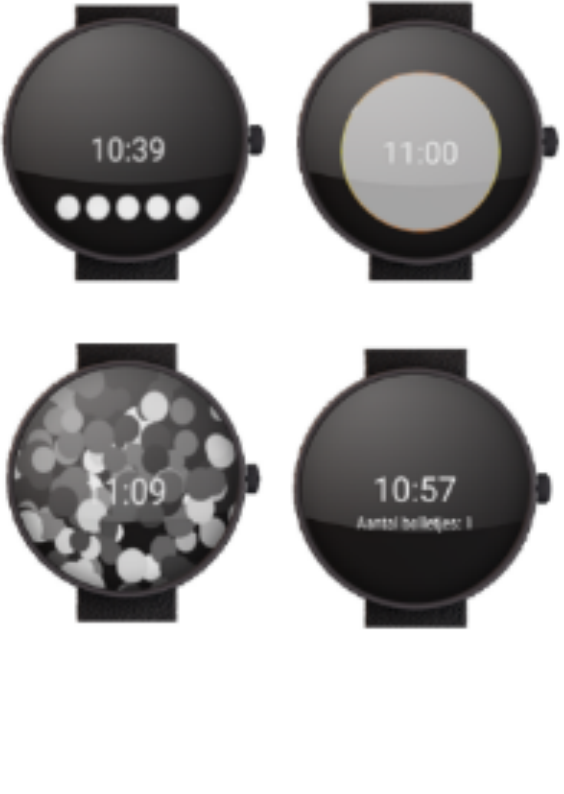
Figure 2. Sense-IT watch faces, first version. The watch faces each expressed changing levels of HR/PCEA by changing either the circular elements (ie, more circles or a bigger circle), or simply indicating a numerical level (from 1 –